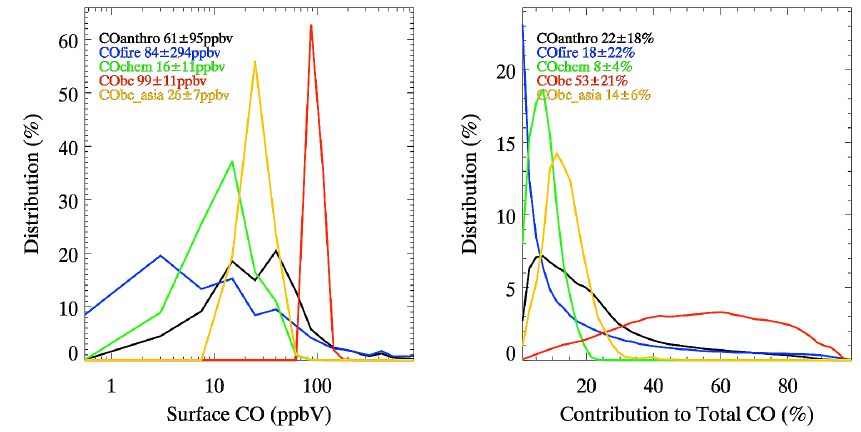
Fig. 7. Frequency distribution of CO tracer mixing ratios (ppbV) (left-hand side) and relative contributions (%) (right-hand side) for surface CO over CA for 20 June–15 July.